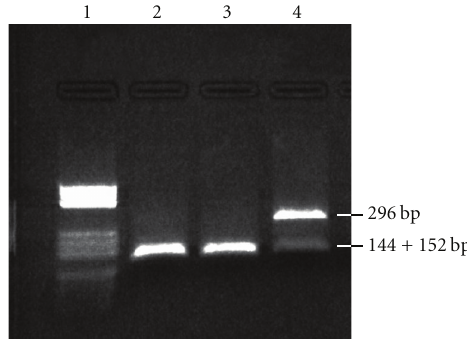
Figure 3: Results of restriction analysis. Lane 1: molecular